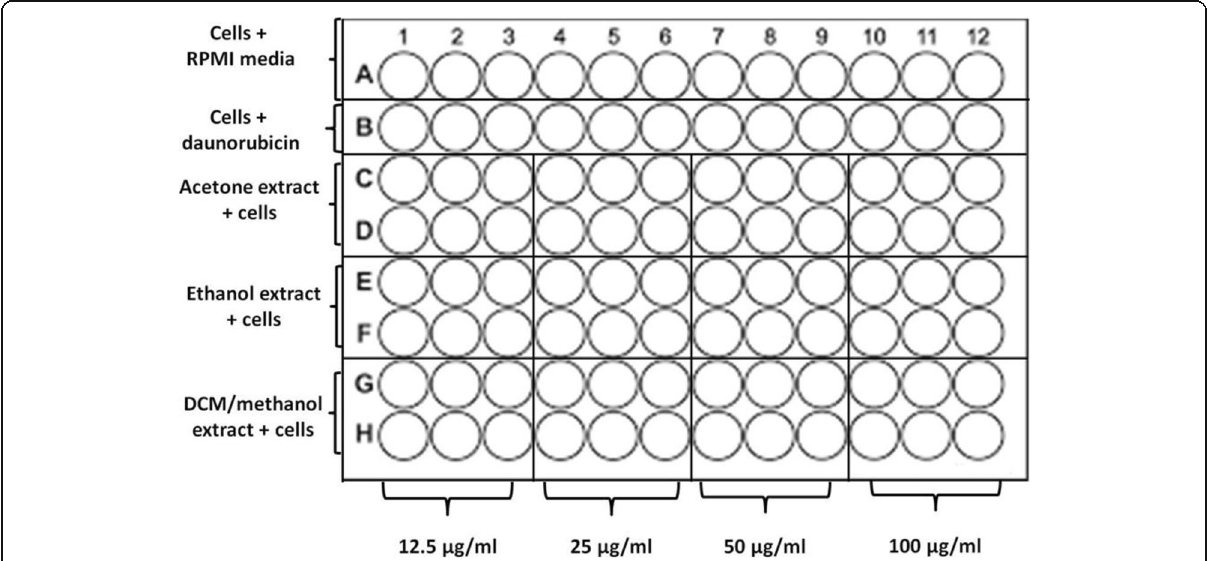
Fig. 1 Plate set up for the MTT assay using mouse peritoneal cells, exposed to different solvent extracts from T. welwitschii leaves. Cells in RPMI row was the negative control, while the cells daunorubicin row was the positive